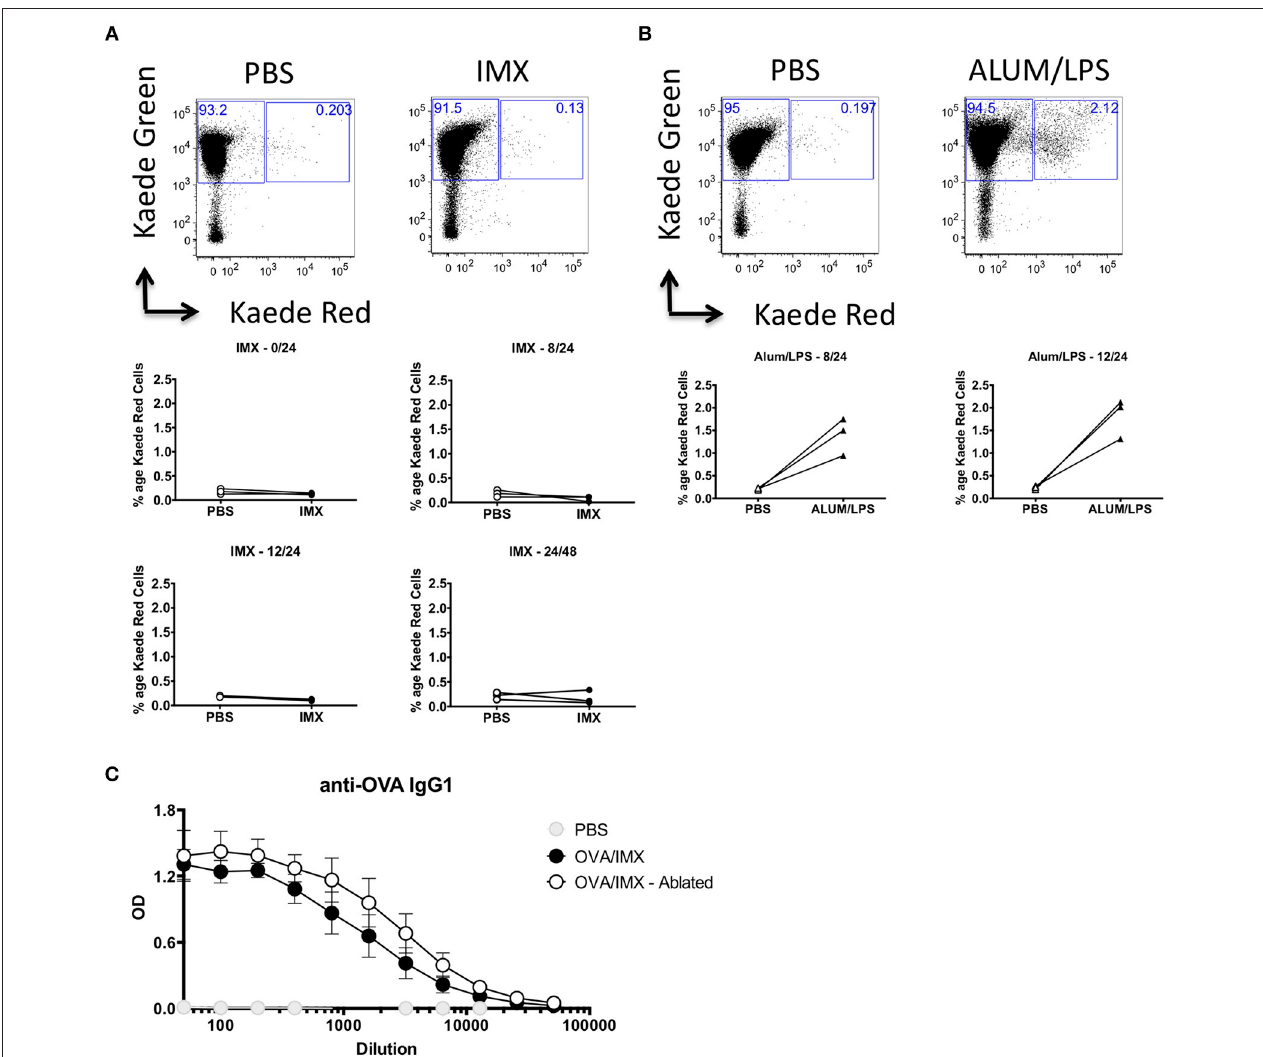
FIGURE 3 | The injection site is not required for ISCOMATRIX adjuvant activity. (A) Representative flow cytometry plots showing Kaede red vs. Kaede green in the popliteal lymph node (top panels) draining the PBS injected (left) and the ISCOMATRIX (right) injected footpad, below plots showing the percentage of the leukocytes in the draining lymph nodes at 24h following photoswitching immediately prior (middle left), 8h post (middle right) 12h post (bottom left) immunization or at 48h from mice photoswitched at 24h (bottom right). (B) Representative flow cytometry plots showing Kaede red vs. Kaede green in the popliteal lymph node (top panels) draining the PBS injected (left) and the ALUM/LPS (right) injected footpad, below plots showing the percentage of the leukocytes in the draining lymph nodes at 24h following photoswitching 8h post (bottom left) and 12h post (bottom right) immunization. (C) Serum anti-OVA IgG1 from mice at 14 days post immunization with PBS, OVA/ISCOMATRIX with the injection site intact or OVA/ISCOMATRIX with the injection site removed shortly following immunization. Groups contained 3 animals and data is representative of two independent experiments. IMX = ISCOMATRIX TM